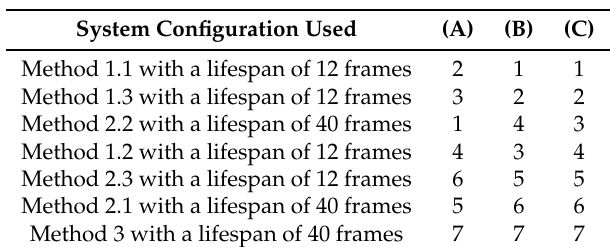
Table 6. Table ranking the best results (A) Ranking of the results according to the average scaled rating in all sections of the video; (B) Ranking of the results according to the rankings in all sections of the video, except for the first and last